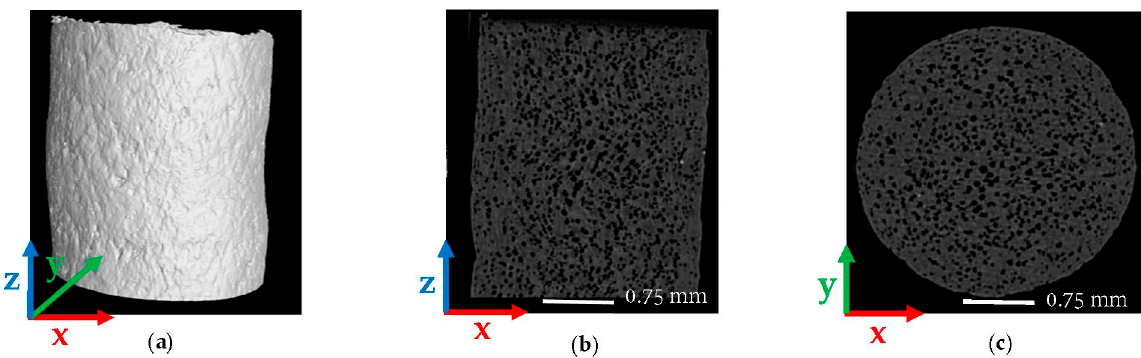
Figure 4. µCT images of a SCF/ABS single freely extruded strand: ( a ) 3D view; ( b ) 2D front view; ( c ) 2D top view.